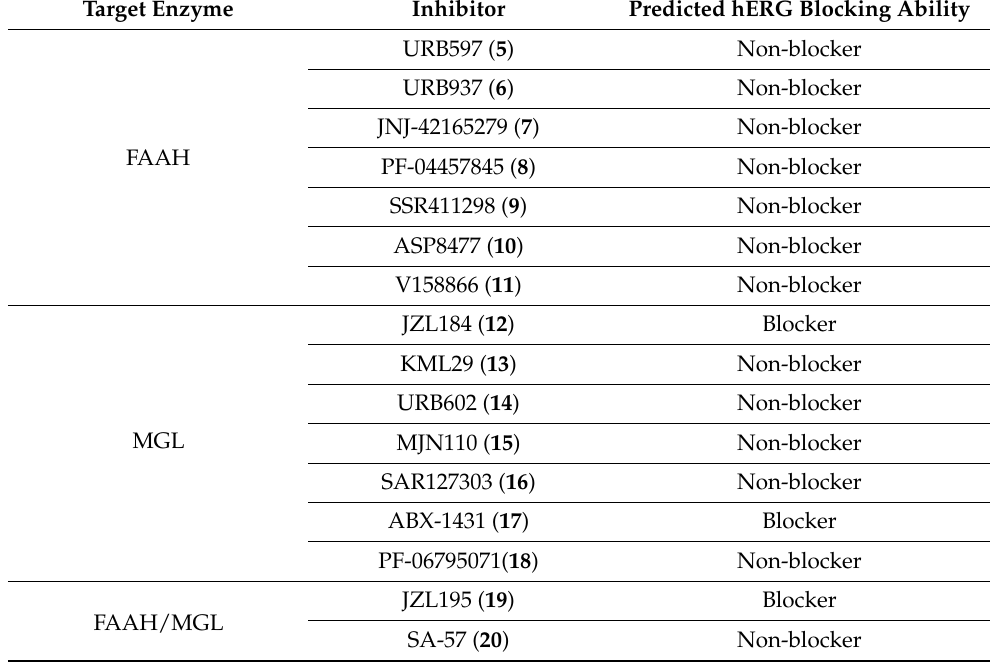
Table 1. Results returned by the ligand-based classifier recently published by Delre et al. [120]. Notice that an IC 50 = 10 µ M was used as the threshold. Target Enzyme Inhibitor